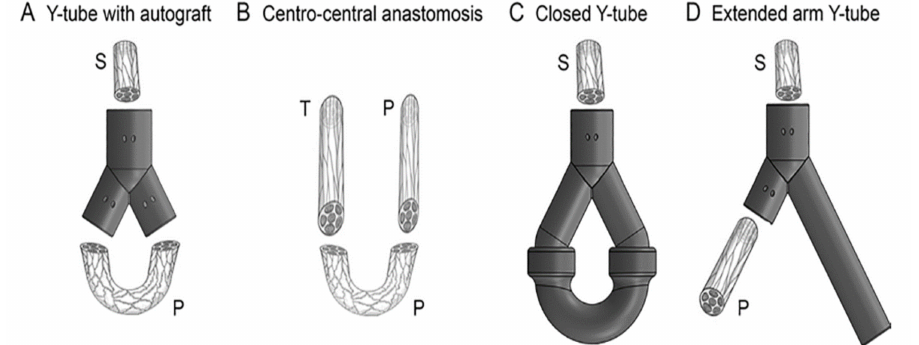
Figure 11. Diagram of different types of nerve repair. ( A ) The open Y-tube, in which the proximal sciatic nerve (S) is inserted into the single arm of the conduit and a 10-mm-long peroneal (P) nerve graft is connected to the distal arms of the Y-tube to create a closed loop. ( B ) The CCA, which is formed by the direct coaptation of the proximal tibial (T) and peroneal nerves, placing between them a 10-mm-long peroneal nerve graft. ( C ) The closed Y-tube, in which the proximal sciatic nerve is inserted into the conduit. ( D ) The extended-arm Y-tube, which has an extended plastic arm and a 5-mm extended peroneal nerve graft